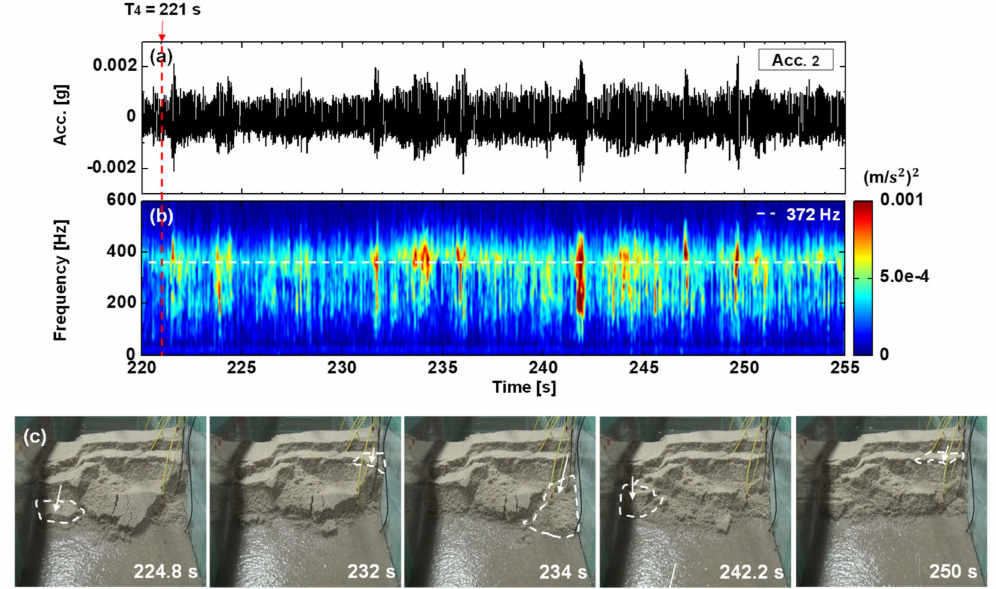
Figure 10. Event 5, the successive slide: ( a ) seismic signal, ( b ) time–frequency spectrum, ( c ) series of front views of the successive slide.